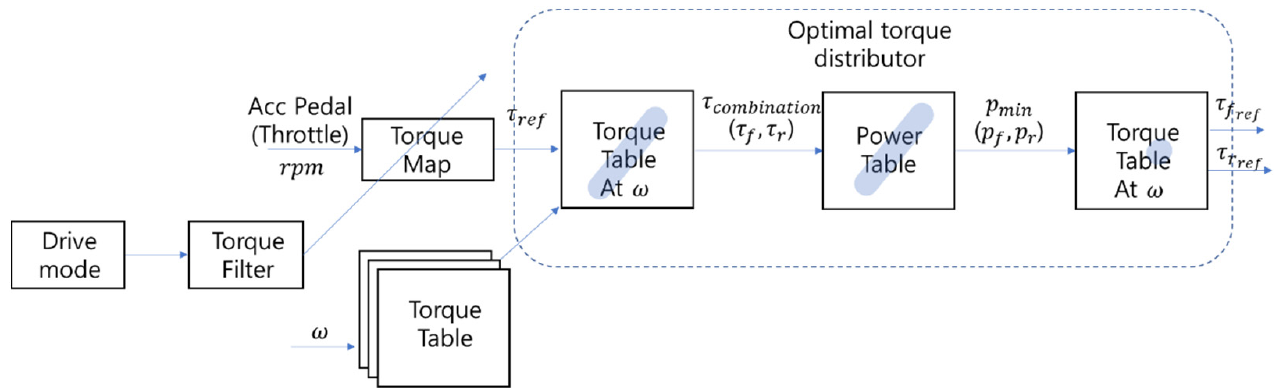
Figure 6. Torque Matching Strategy Scheme.